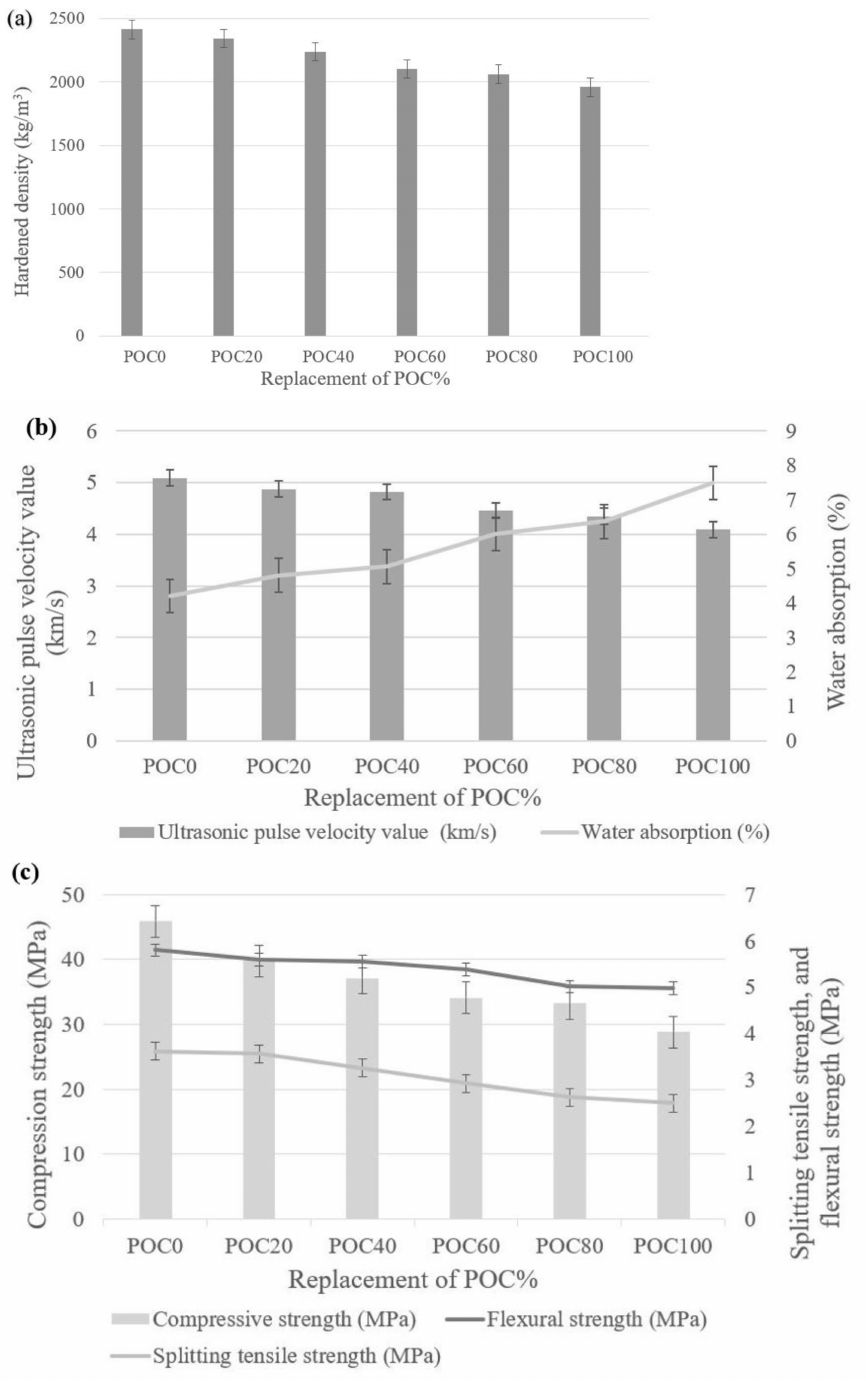
Figure 4. Mechanical properties of palm oil clinker concrete. ( a ) Hardened density, ( b ) ultrasonic pulse velocity value and water absorption, and ( c ) compression strength, splitting tensile strength, and flexural strength at different replacements level of